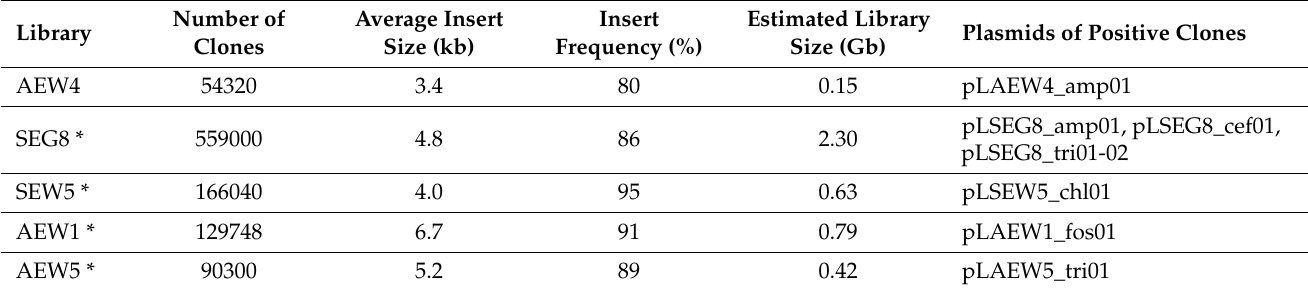
Table 1. Characteristics of soil metagenomic libraries and designation of plasmids harbored by positive clones.